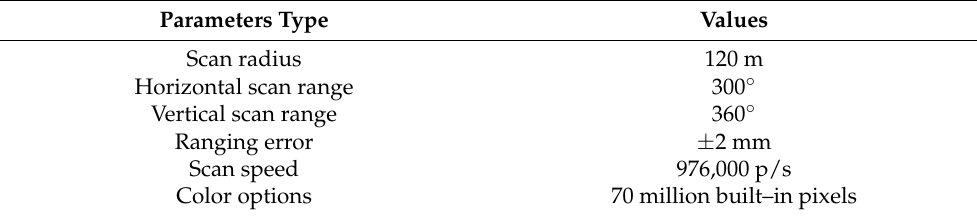
Figure 2. The original data with RGB color. ( a ) Top view of the original data; ( b ) Front view of original data. Table 1. Parameters of FARO light detection and ranging